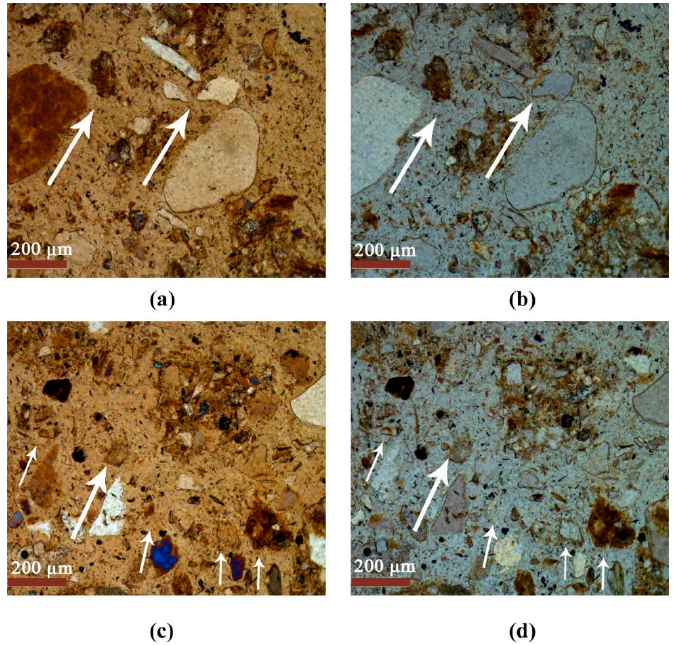
Figure 6. Vertical orientation of subangular blocky quartz (S 1 − 1). ( a , c ) Plane polarized light; ( b , d ) crossed polarized light.